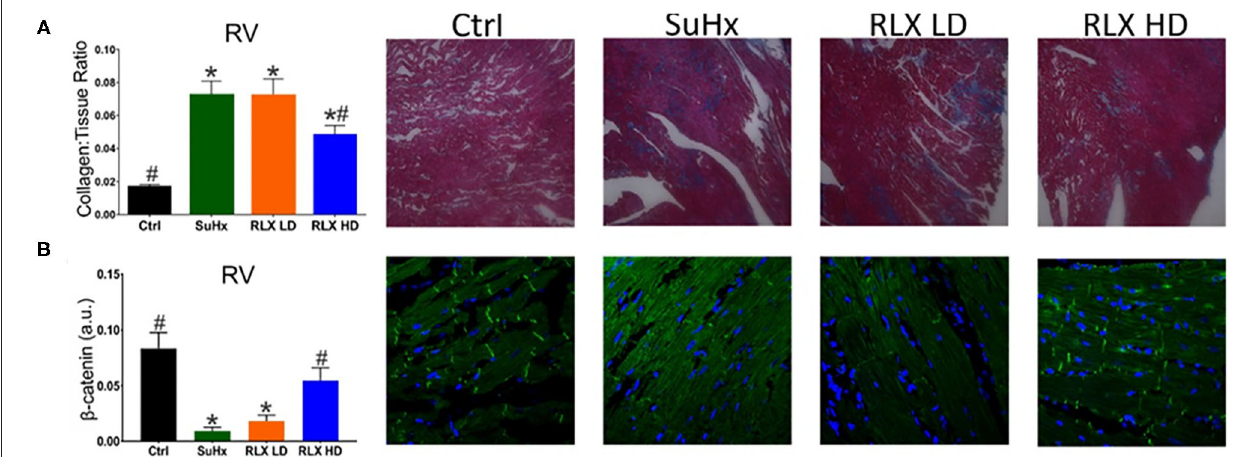
FIGURE 3 | Effects of RLX on RV fibrosis and cell-cell coupling. (A) PAH (SuHx) hearts developed an increase in fibrosis that was prevented by treating rats with SuHx + RLX-HD [ (A) : RLX-HD panel], but not in rats treated with SuHx + RLX-LD [ (A) : RLX-LD panel]. (B) RV cell-cell junctions were disrupted by SuHx treatment compared to controls, as measured by β -catenin expression and β -catenin localization to intercalated disk (Ctrl). PAH rats (SuHx) had a marked reduction of β -catenin expression [ (B) : SuHx panel] compared to control rats [ (B) : Ctrl panel]. PAH rats treated with RLX-LD [ (B) : RLX-LD panel] did not show appreciable differences in β -catenin compared to rats treated with SuHx, alone. In PAH rats, RLX-HD treatment significantly prevented the reduction of β -catenin expression [ (B) : RLX-HD panel] ( n ≥ four animals/per group. *Indicates p < 0.05 vs. control. # Indicates p < 0.05 vs.